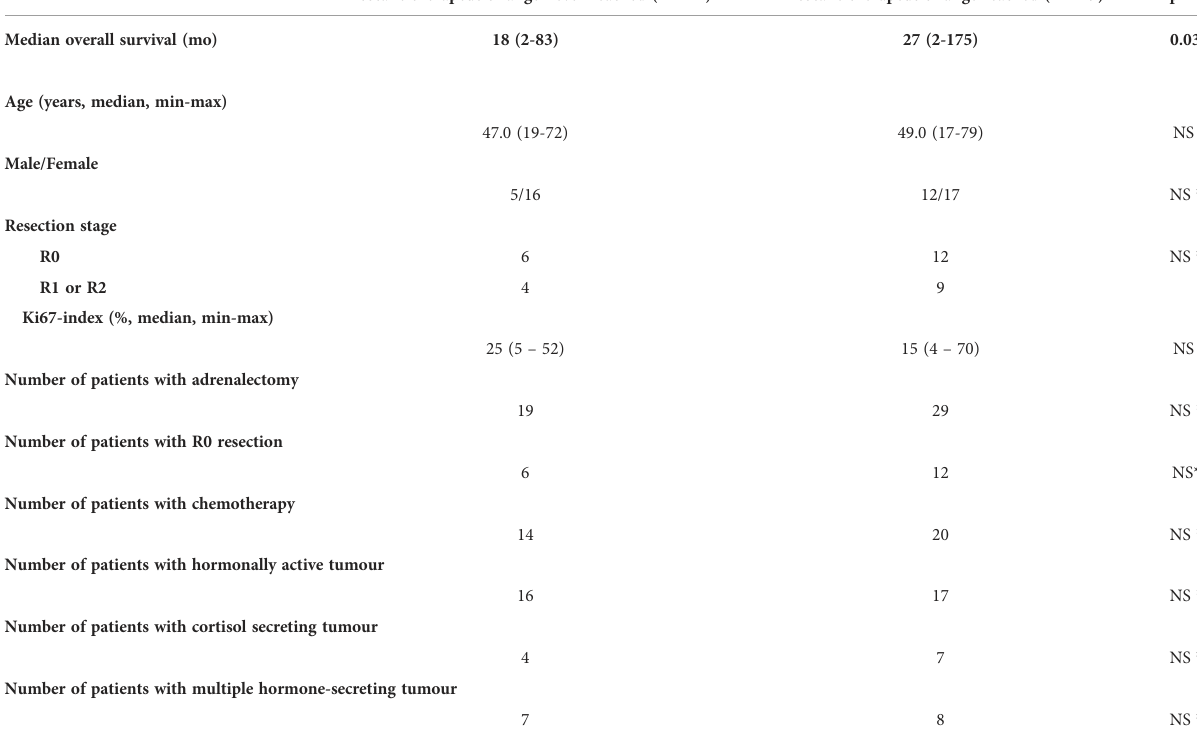
TABLE 4 Clinicopathological characteristics of patients who reached vs never reached therapeutic mitotane range. Mitotane therapeutic range never reached (n =